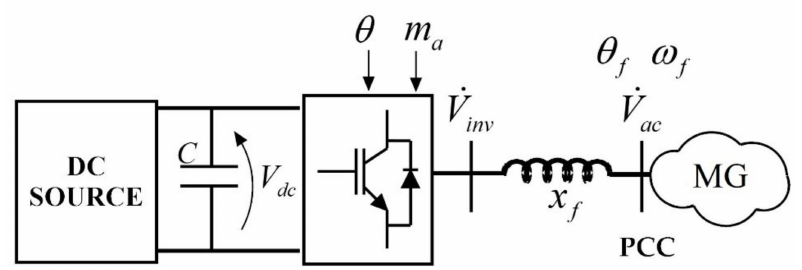
Figure 5. DG simplified layout used for the MPC controller